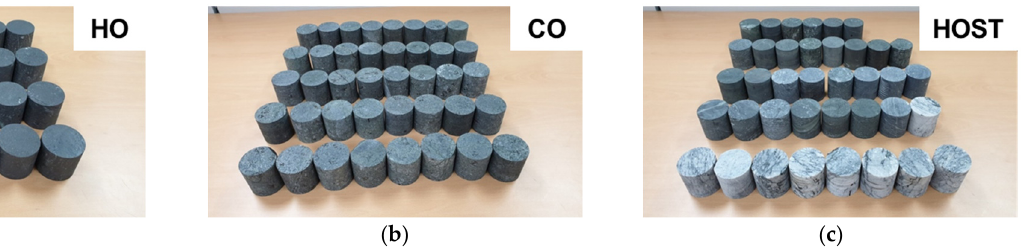
Figure 2. Classified rock samples by density: ( a ) high ‐ grade ore (HO) (>4.4 g/cm 3 ), ( b ) candidate ore (CO) deposits (3.5–4.4 g/cm 3 ), and ( c ) host rock (HOST) (<3.5 g/cm 3 ).